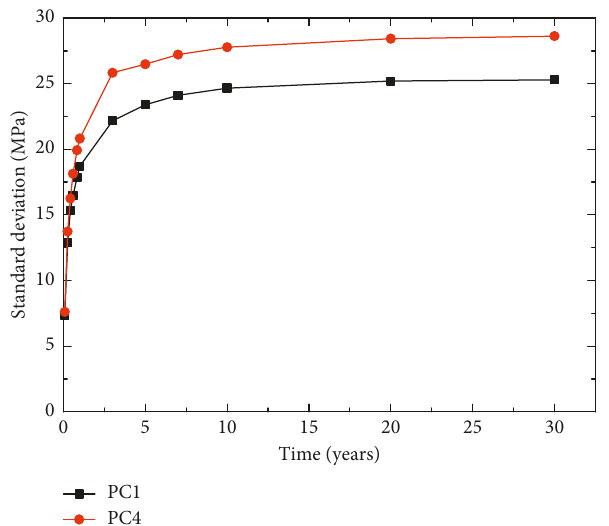
Figure 10: Time-varying SDs of long-term loss.